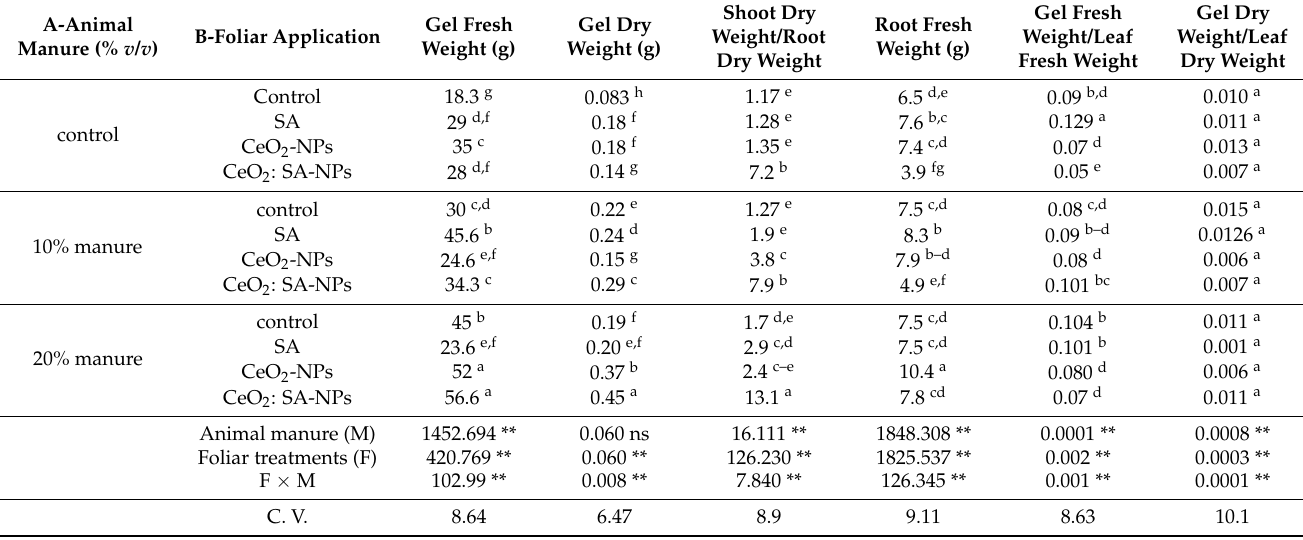
Table 4. Interaction effects of soil-based animal manure (0%, 10%, and 20% v / v ) use and foliar applications (no-foliar, SA, CeO 2 -nanoparticles, and CeO 2 : SA-nanoparticles) on Aloe vera L. plants’ growth and physiological